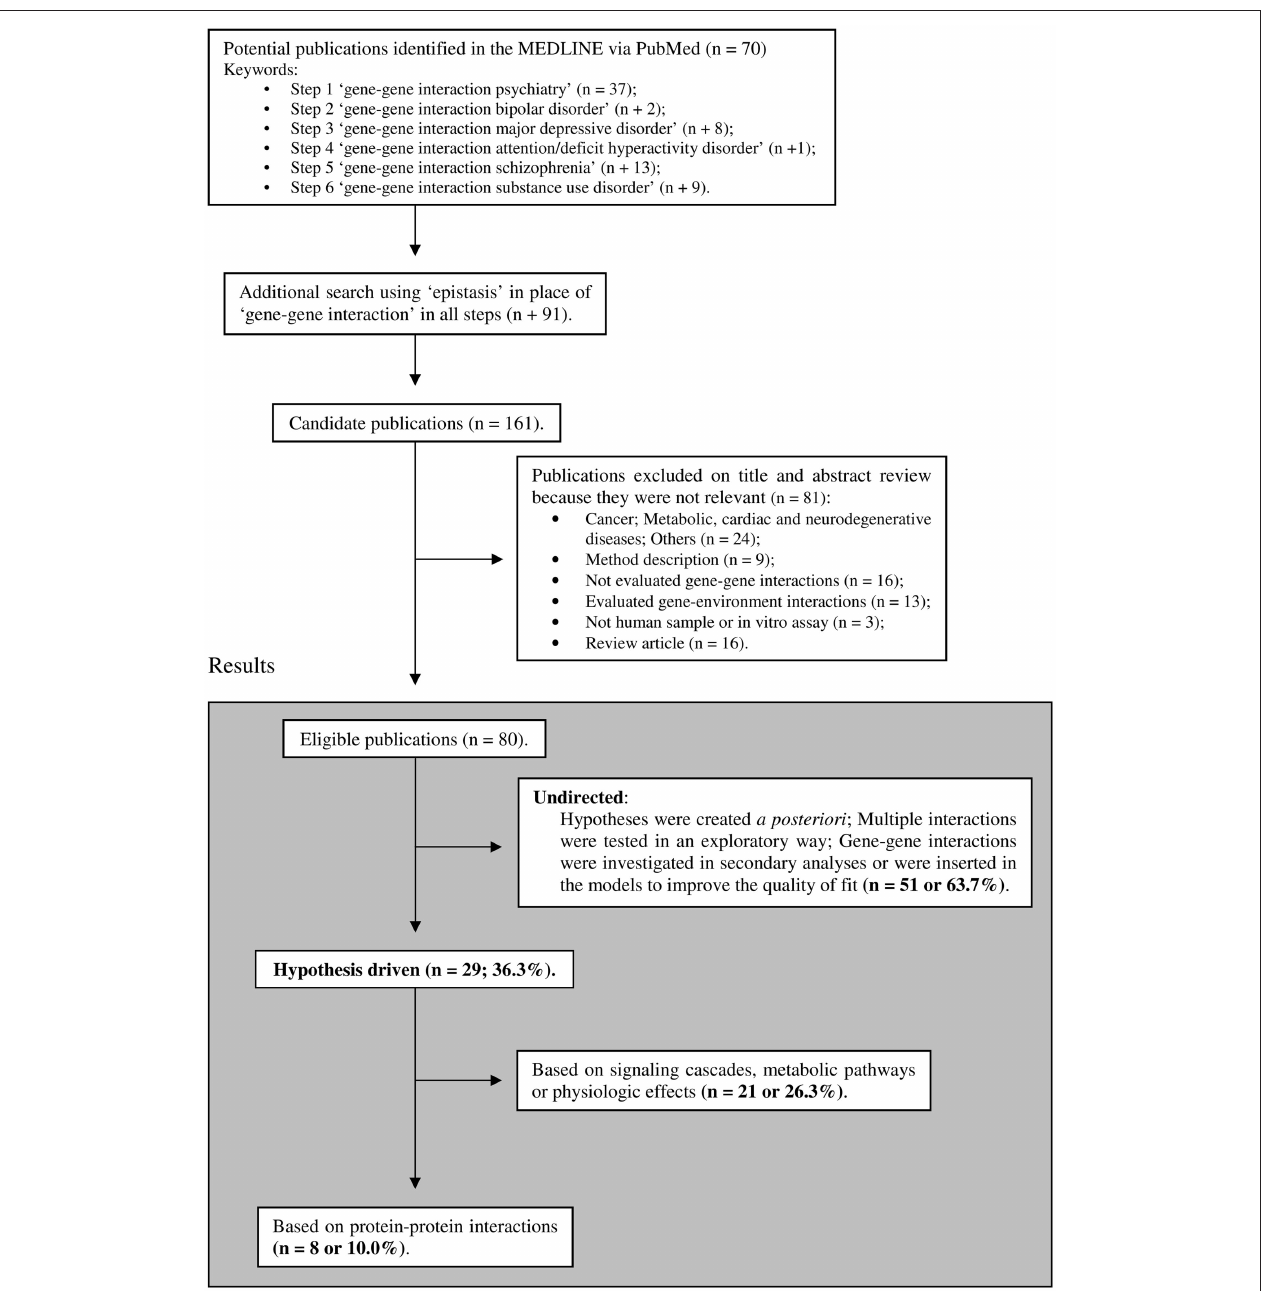
Figure 1 | Selection of studies included in the review. The limits were: publication in the last 5 years (published until January, 2013), humans, English language, full text available, and MEDLINE. The list of included articles is available